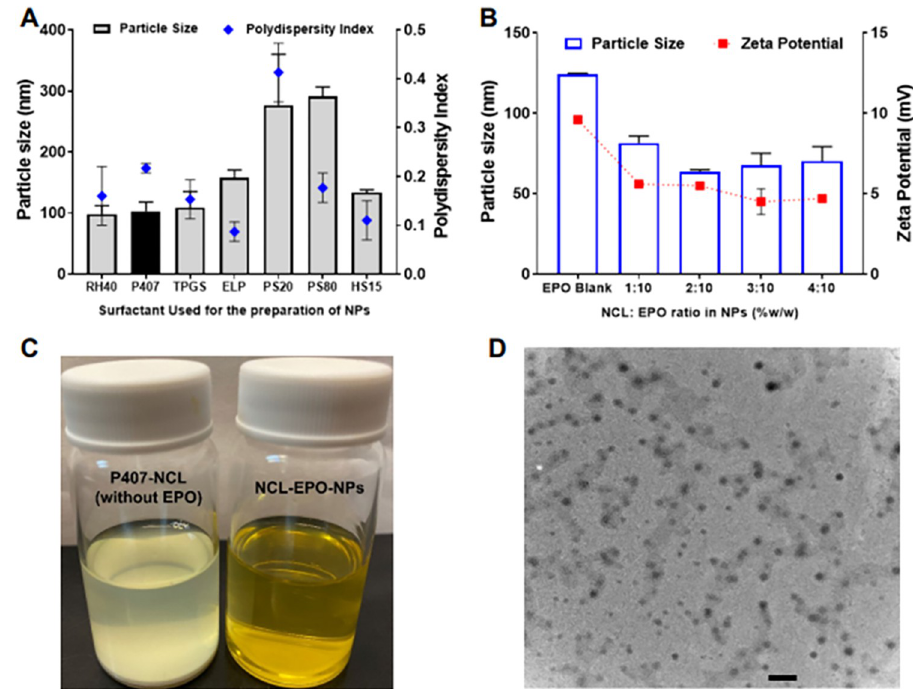
Fig 2. Development of Poloxamer 407 stabilized Eudragit EPO NPs with high niclosamide loading (NCL-EPO-NPs). (A) Screening of various FDA-approved surfactants for the development of NCL-EPO-NPs. RH40: Kolliphor RH 40; P407: Poloxamer 407; TPGS: Vitamin E TPGS; ELP: Kolliphor ELP; PS 20: Polysorbate 20; PS80: Polysorbate 80; HS 15: Kolliphor HS 15. P407-stabilized NCL-EPO-NPs were selected for the further characterization and studies. Data expressed as mean ± SD ( n = 3). (B) Effect of NCL loading on the size and zeta potential of EPO NPs. It was possible to obtain stable NCL-EPO-NPs with high NCL loading of 40% w/w of EPO. The polydispersity index value for all samples was < 0.26. Data expressed as mean ± SD ( n = 3). (C) A representative image to demonstrate critical role of Eudragit EPO for the formation of stable NCL-EPO-NPs. In the absence of Eudragit EPO, niclosamide immediately precipitated indicating the importance of Eudragit EPO. (D) TEM image of P407-NCL-EPO-NPs. The NPs showed spherical morphology and a reasonable correlation with the dynamic light scattering data. (Scale bar = 200 nm). Raw data are found in the file S1 Data. NCL, niclosamide; NCL-EPO-NP, NCL-loaded EPO NP; NP, nanoparticle; TEM, transmission electron